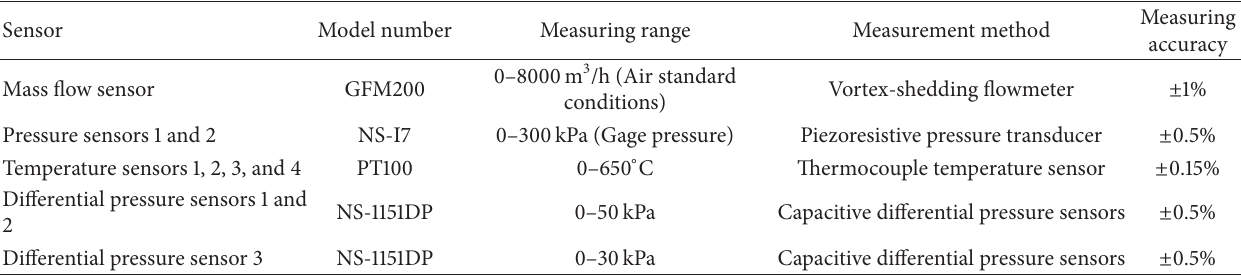
Table 1: Details of main